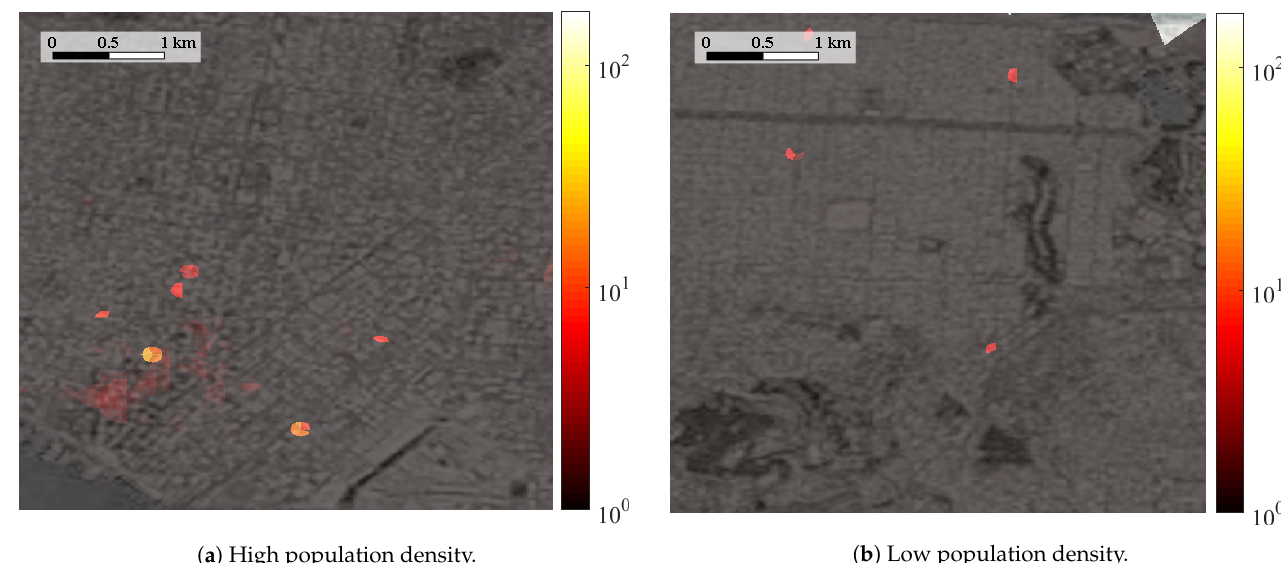
Figure 6. Results of M UE with the E-CID model in the sections presented in Figure 4.